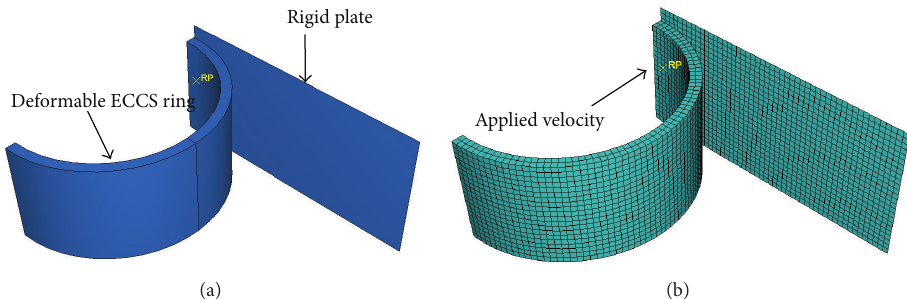
Figure 2: Simplified model for drop load calculation. (a) Finite element model parts. (b) Meshed finite element model and applied velocity.